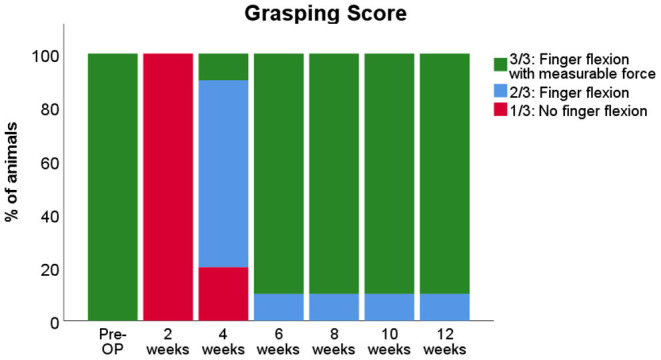
Evaluation of the grasping ability prior to and following median nerve resection and autograft repair in rats. Note that although all rats recovered the ability of finger flexion with measurable force by 8 weeks post-operatively (WPO8), some animals displayed reduced motivation to participate in the reflex-based grasping test at various time points, indicated by the percentage of animals that showed finger flexion without measurable force from WPO6 throughout WPO12.